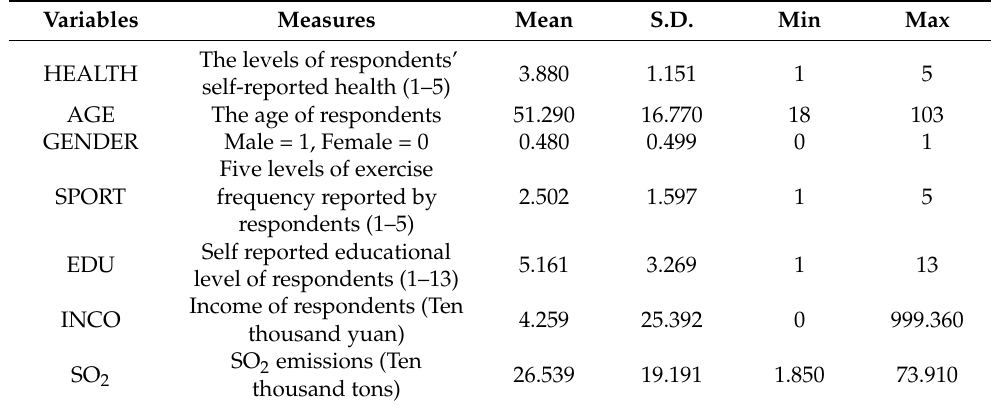
Table 1. Descriptive statistics.